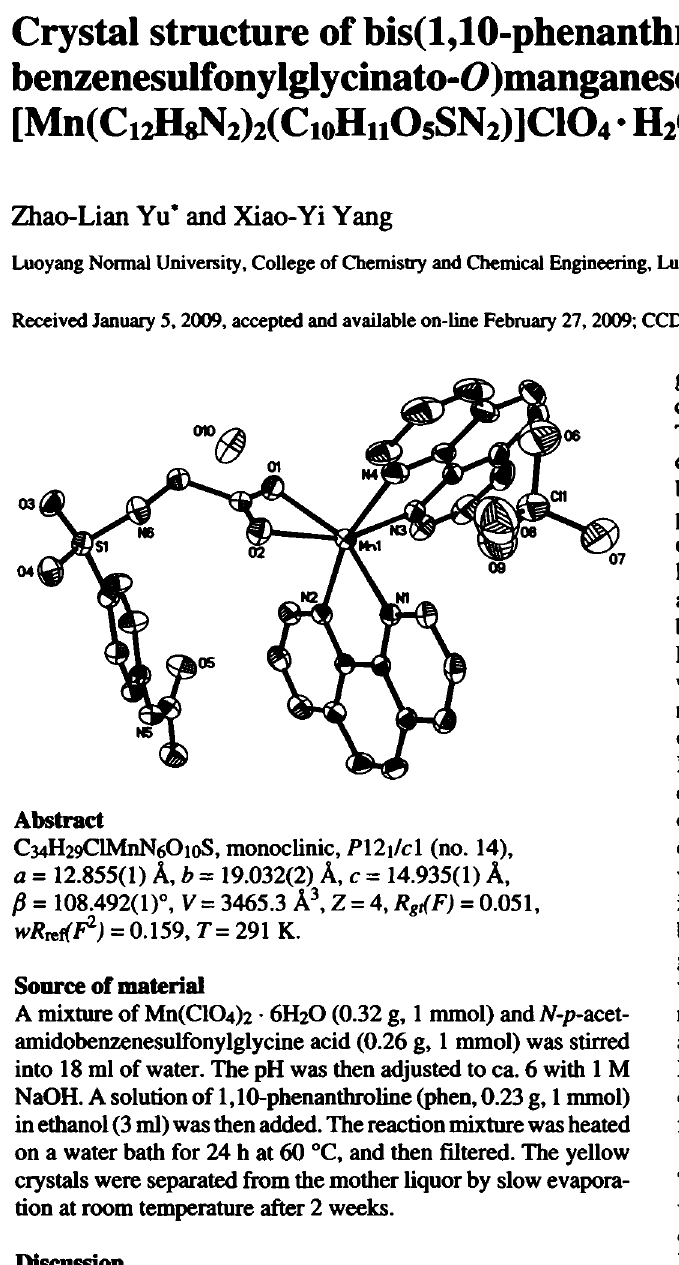
Table 1. Data collection and handling.